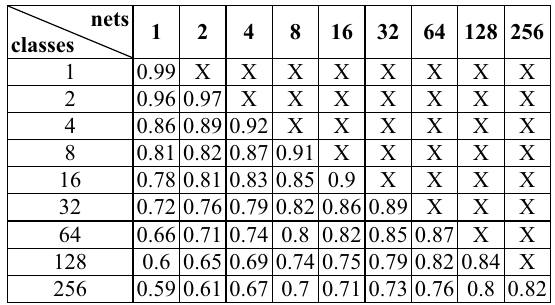
Table 1. The table of dependence of classification quality on various test sample classes and neural networks number.